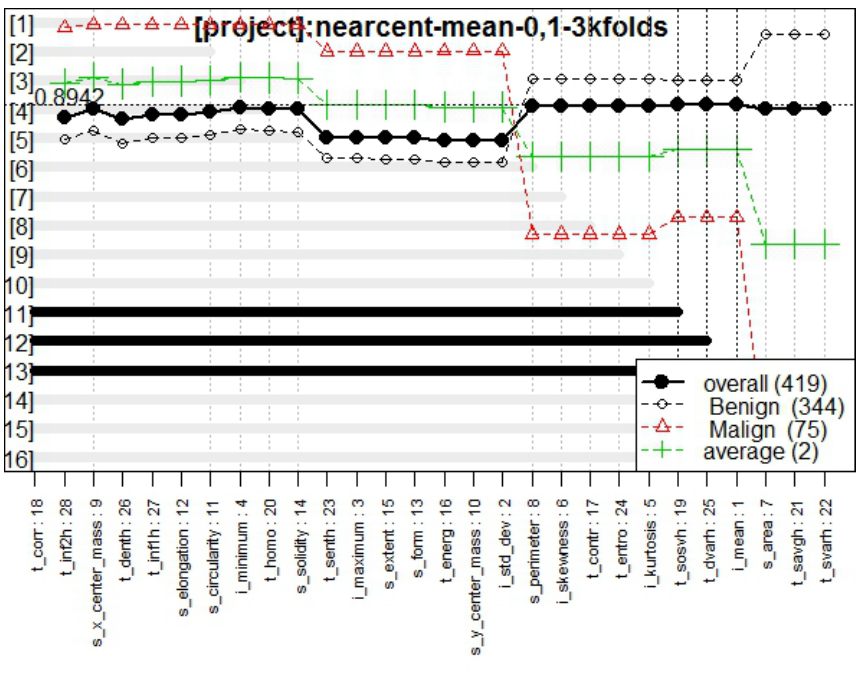
Figure 6. Genes behavior through Galgo algorithm with NC